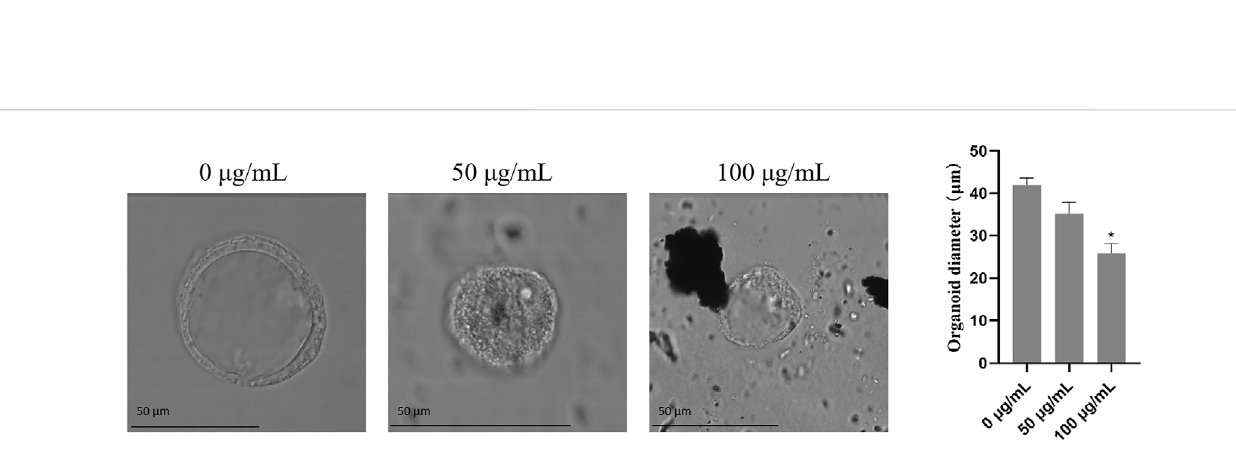
Frontiers in Bioengineering and